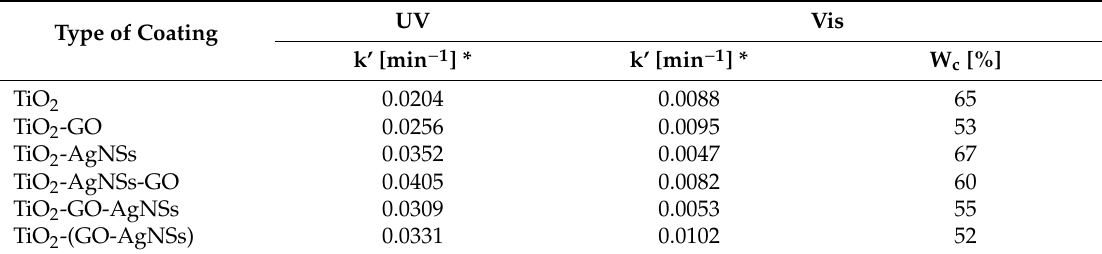
*—The error (standard deviation) of reaction rate constant is lower that